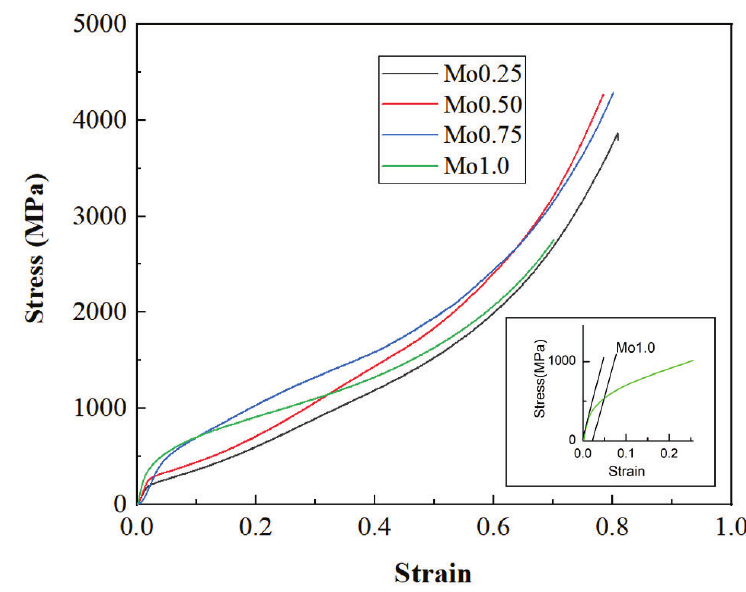
Figure 5. Room-temperature compressive stress-strain curves of CoFeNiMnMo x ( x = 0.25, 0.5, 0.75 and 1.0) alloys and enlarged scans for the CoFeNiMnMo alloy. Table 4. Room-temperature compressive properties of the studied CoFeNiMnMo x alloys and